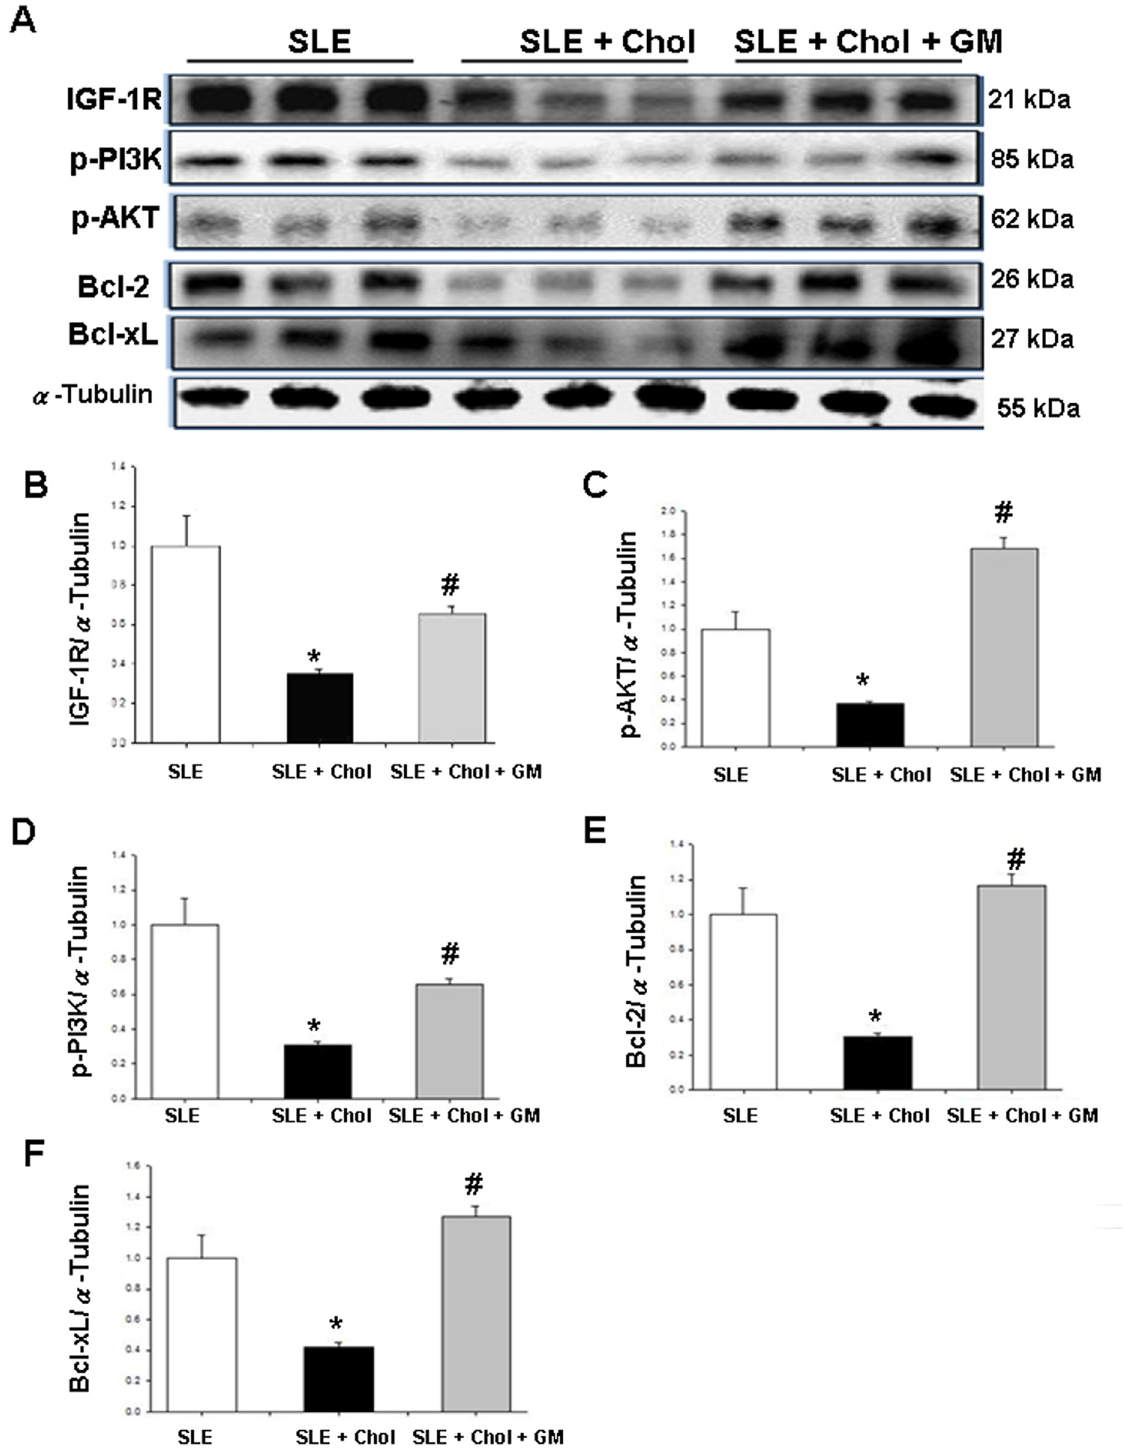
Fig 4. Expression of cardiac survival signal in left ventricular tissues of NZB/W F1 mice fed with different dietary supplements. (A) Expressions of IGF-1R, p-PI3K, p-AKT(Ser473), Bcl-2 and Bcl-xL in left ventricles of hearts from NZB/W F1 mice fed with different supplements, as measured by Western blotting analysis. α -Tubulin used as an internal control. Bars represent quantities of (B) IGF-1R, (C) p-PI3K, (D) p-AKT(Ser473), (E) Bcl-2 and (F) Bcl-xL proteins relative to quantity of α -Tubulin. * and # indicate significant differences relative to SLE and SLE + cholesterol groups, respectively. Similar results were obtained in triplicate experiments. SLE: systemic lupus erythematosus; Chol: cholesterol; GM: Gentiana macrophylla Pall.